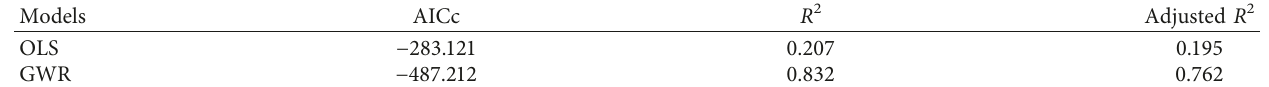
Table 2: GWR performance